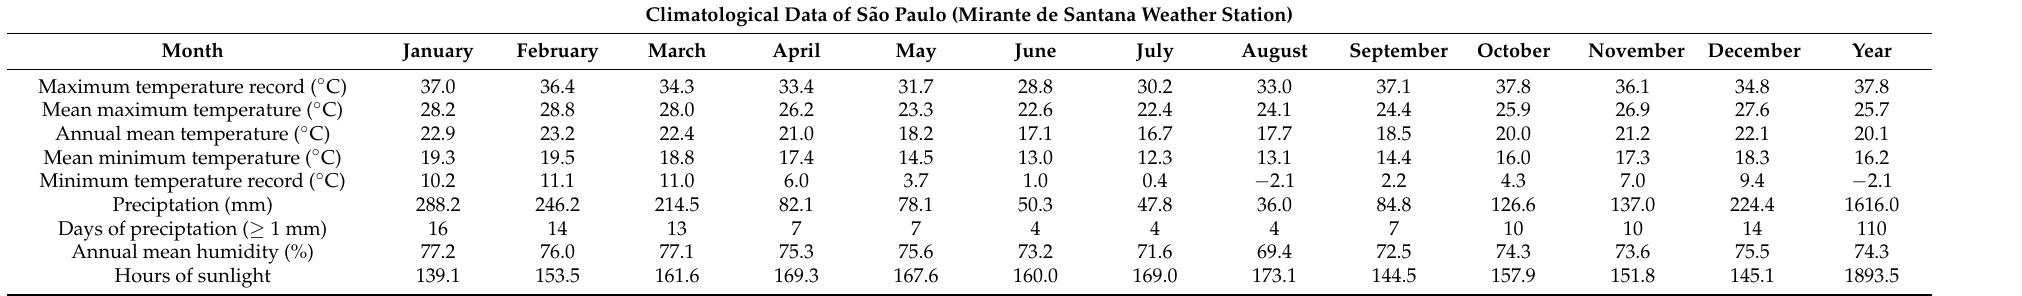
Table 2. Climatological data of S ã o Paulo from Mirante de Santana weather station, calculated by the National Institute of Meteorology (INMET) of Brazil according to the World Meteorological Organization (WMO) requirements. Source: National Institute of Meteorology (INMET) of Brazil, normal climatological of 1981–2010 and records of temperature from 1945 to present. Table elaborated by authors